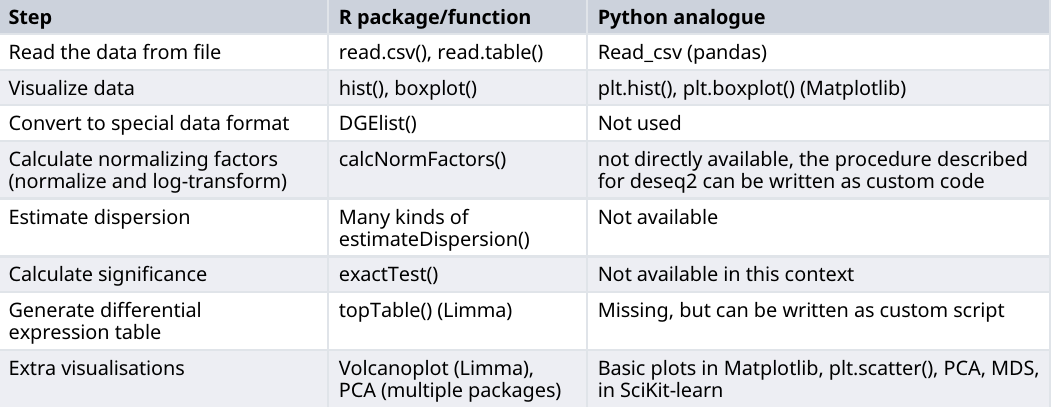
Table 3. Steps and functions for RNAseq DE analysis in edgeR and analogues in